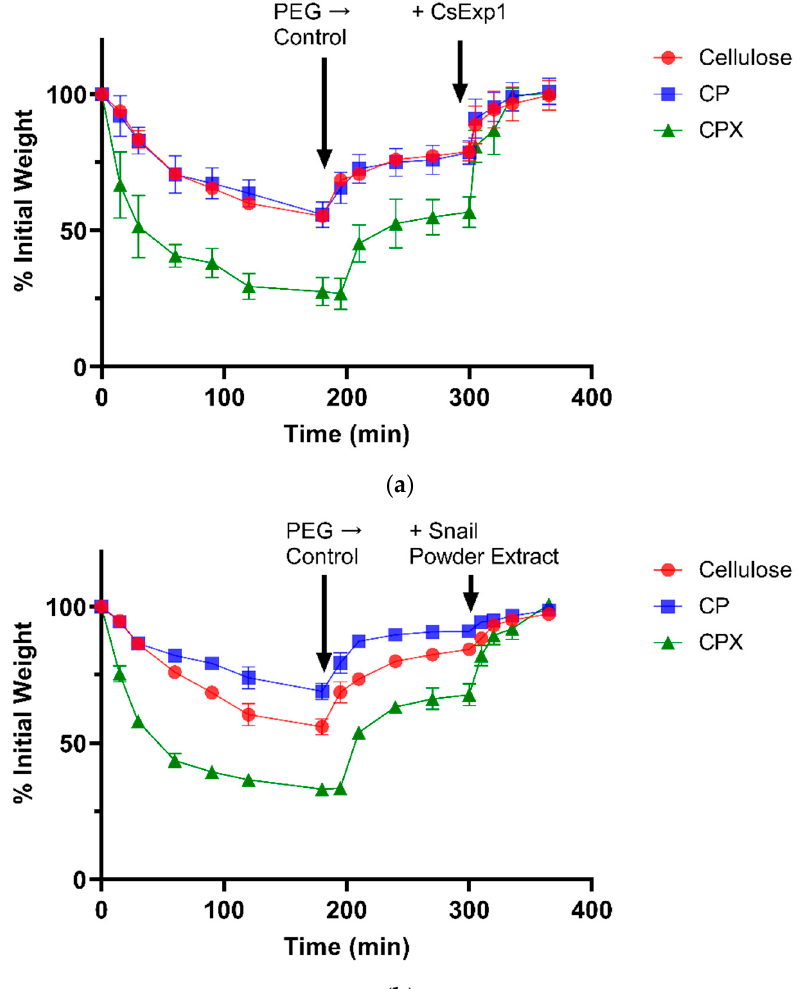
Figure 2. Time course of changes in hydration in pieces of bacterial cellulose (red circles), bacterial cellulose composite with apple pectin (blue squares), and bacterial cellulose composite with apple pectin and xyloglucan (green triangles) after the materials were immersed in buffer with an osmotic potential of − 0.62 MPa (at 0 h), then returned to control buffer (first arrow), and finally treated with 11.2 μ g of α -expansin (second arrow in ( a )) or 200 μ L of snail powder extract (second arrow in ( b )). Error bars indicate S.D. ( n = 3).